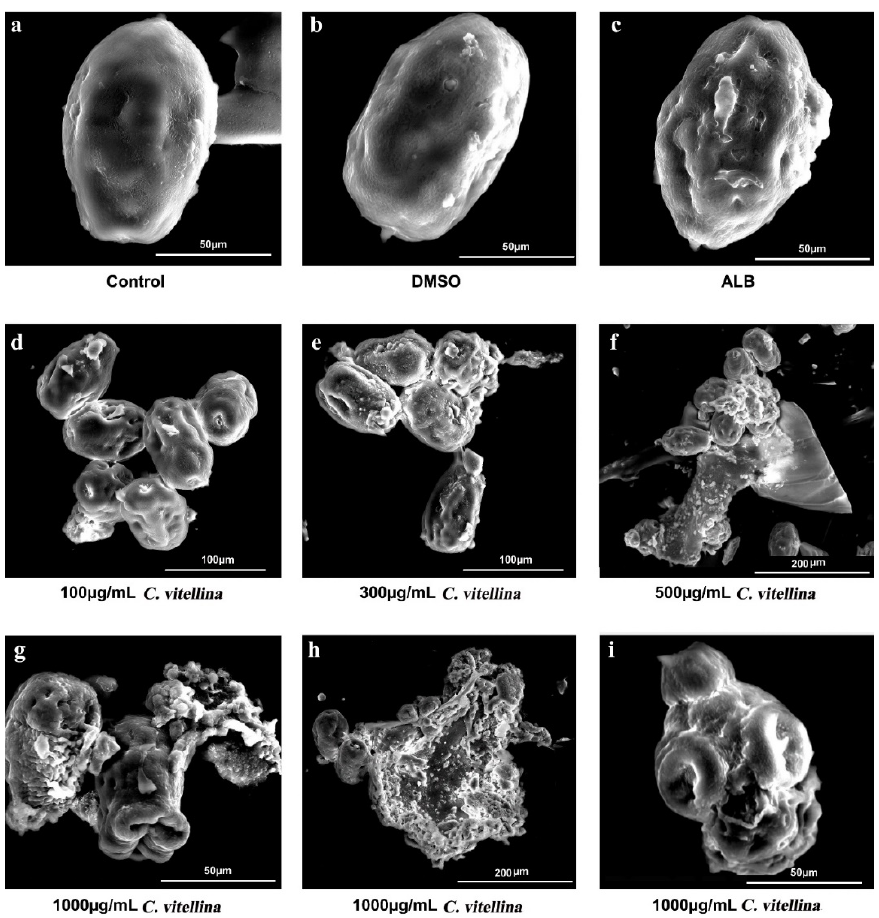
Figure 8. Representative ultramicrographs show the scolicidal effects of C. vitellina extract on the morphology of E. granulosus protoscoleces after 3 h of the incubation. Where ( a ), control; ( b ), DMSO; ( c ), Albendazole; ( d ), 100 µ g / mL; ( e ), 300 µ g / mL; ( f ), 500 µ g / mL; ( g – I ), 1000 µ g / mL of the extract. The experiment was done in triplicate (n = 3). ALB: Albendazole (50 µg/mL).